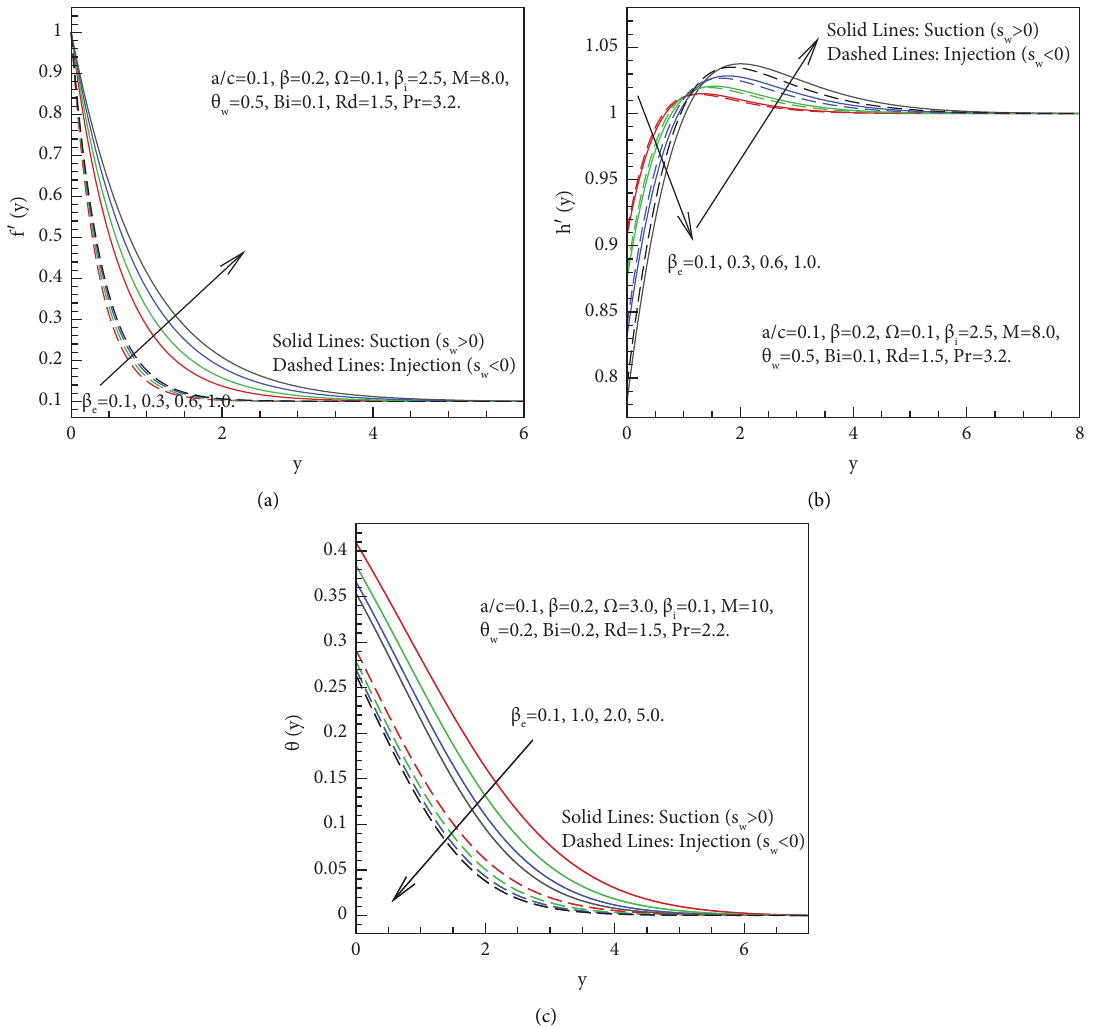
Figure 4: (a) Velocity distribution f ′ ( y ) , (b) velocity distribution h ′ ( y ) , and (c) temperature distribution θ ( y ) for Hall parameter β Figure 6 is plotted for inspecting the performance of radiation parameter Rd , Biot number Bi, and Prandtl